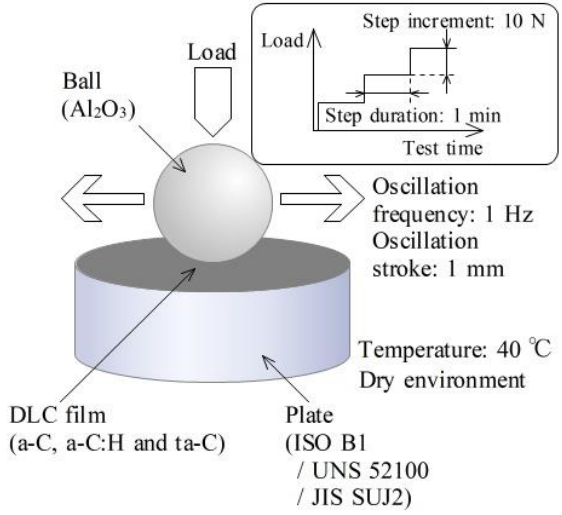
Figure 1. Experimental setup. Table 1. Specifications of DLC films (a-C, a-C:H, and ta-C).